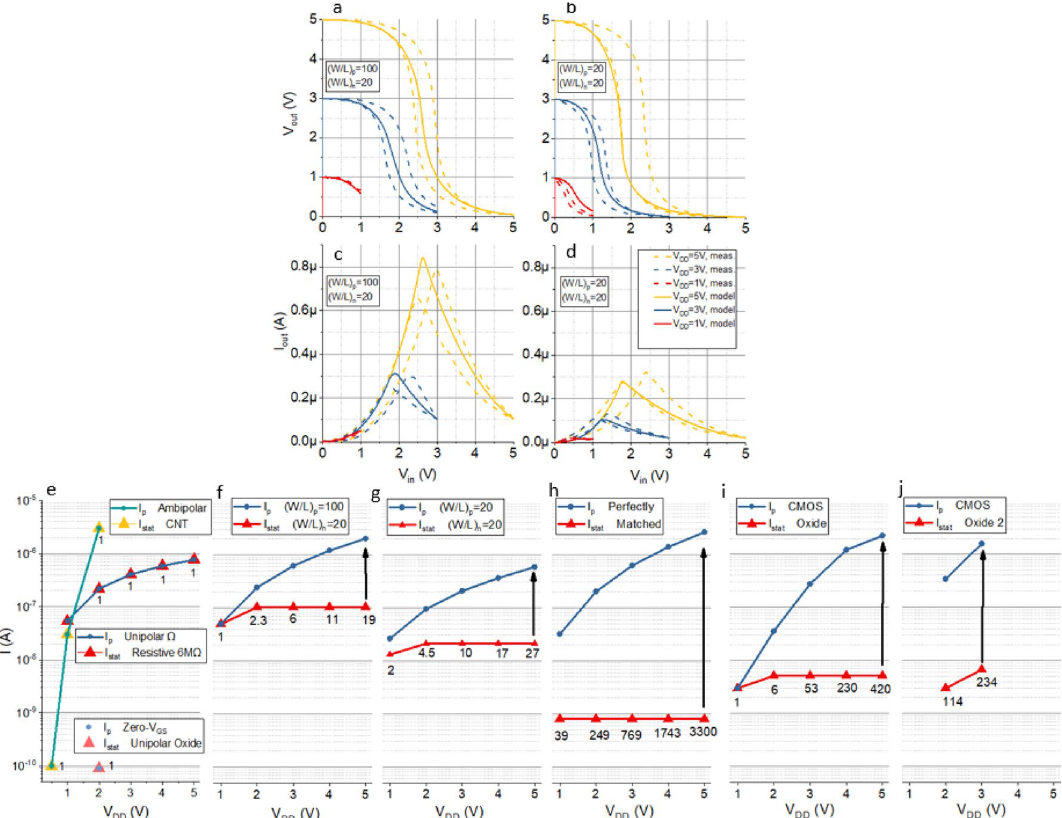
Figure 4. Measured and modelled (solid line) voltage transfer characteristics for the a-ISO + SnO inverters ( a , b ) and current transfer characteristics ( c , d ). Peak, static currents and the ratio between them for V DD = [0,5 V] of different inverter configurations ( e ) unipolar resistive, CNT ambipolar 28 , IGZO zero- V GS 29 , ( f ) CMOS a-ISO + SnO (W/L) p /(W/L) n = 100/20, ( g ) CMOS a-ISO + SnO (W/L) p /(W/L) n = 20/20, ( h ) CMOS ISO perfectly matched, ( i ) CMOS IGZO + SnO 22 , ( j ) CMOS IGZO + SnO 30